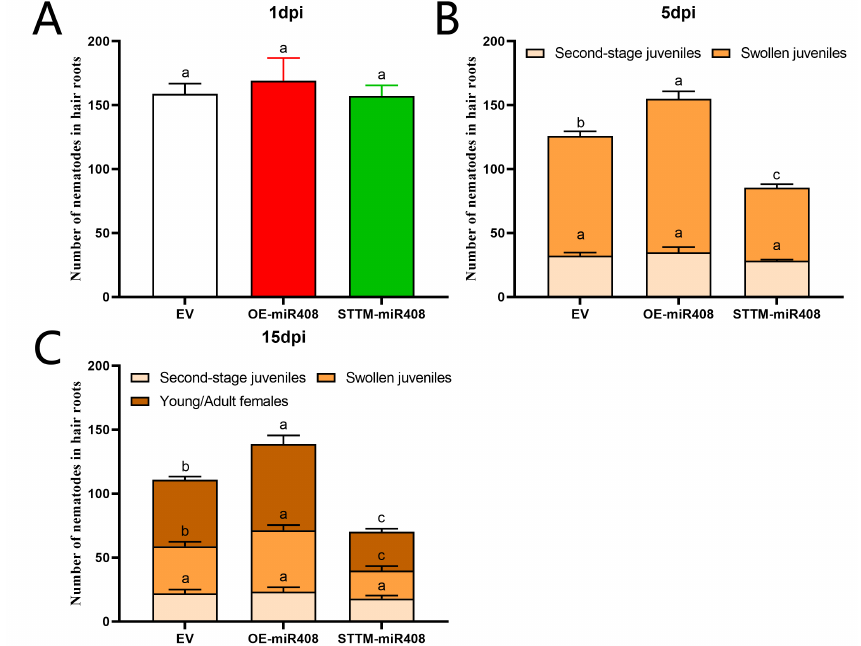
Figure 10. Infection and development of soybean cyst nematode in transgenic hairy roots. ( A ) Num- ber of second-stage juveniles (J2s) in soybean hairy roots examined at 1 dpi. ( B ) Number of different stages of nematodes in soybean hairy roots at 5 dpi. ( C ) Number of different stages of nematodes in soybean hairy roots at 15 dpi. Multiple statistical comparisons between nematodes in EV and other transgenic hairy roots were made by one-way ANOVA. Different characters mean significant differences found at p <